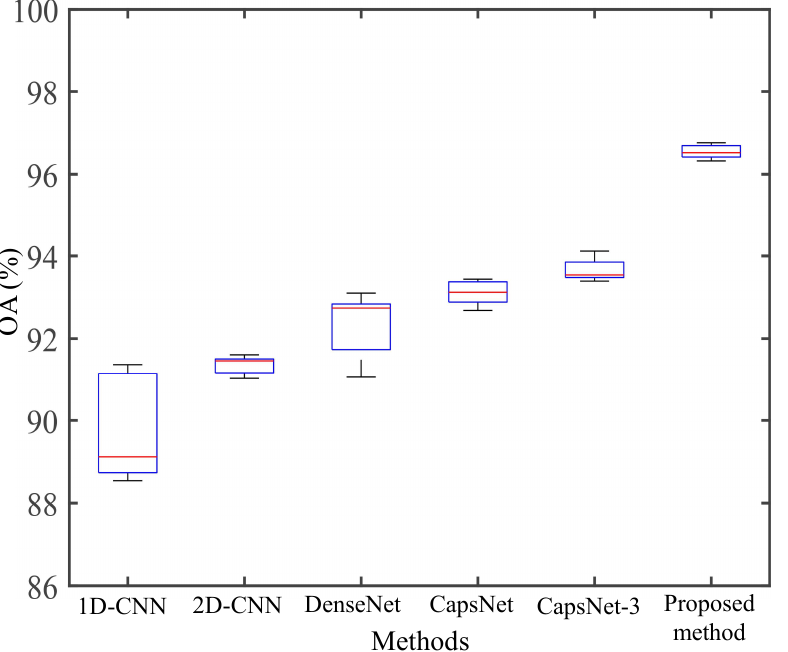
Figure 14. Box plot of the five repeated experimental results on AIRSAR San Francisco